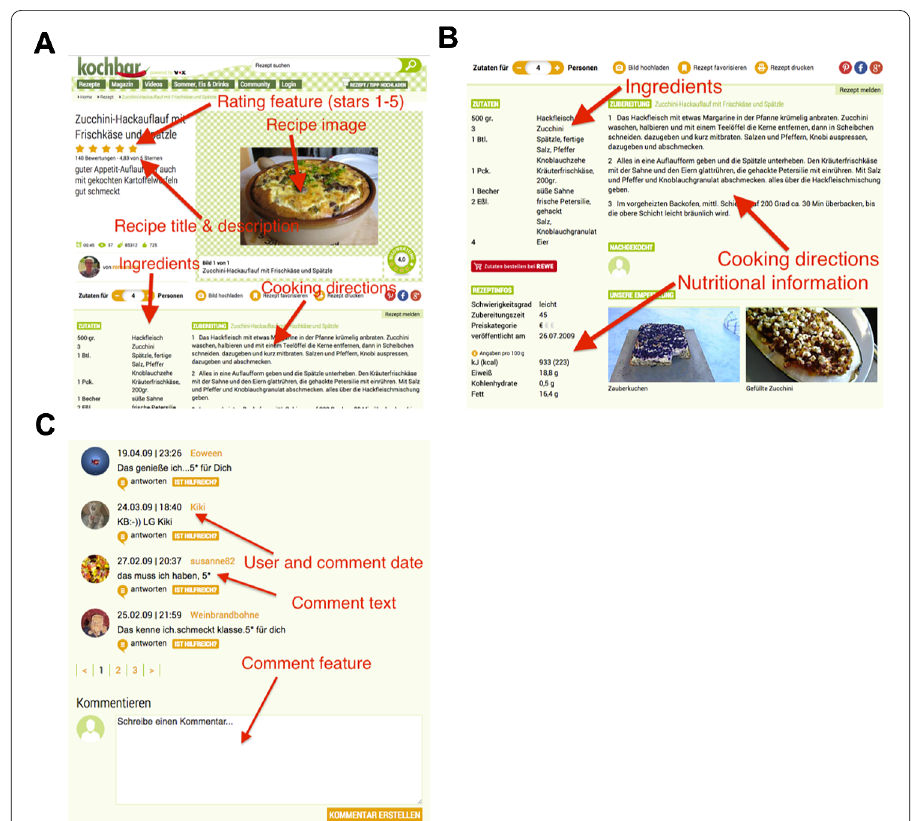
Figure 2 The recipe view of Kochbar.de. Plot ( A ) highlights the top part of the view, showing the main parameters of the recipe and the rating feature ( B ) presents the bottom part of the recipe detail view with the nutritional information on the lower left side ( C ) shows the comments section located at the bottom part of the detail